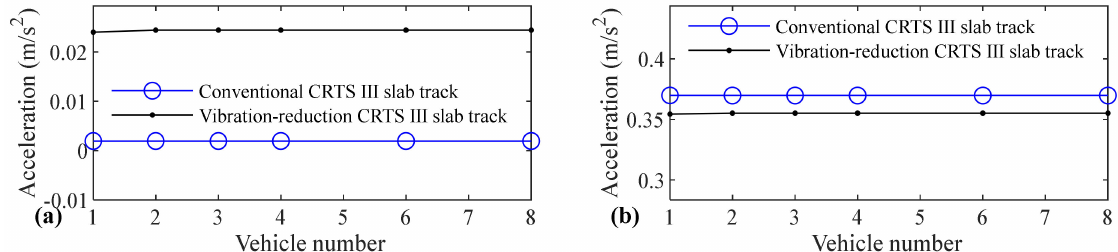
Figure 5. Relation between vehicle number and acceleration of car body: ( a ) without and ( b ) with random track irregularity.